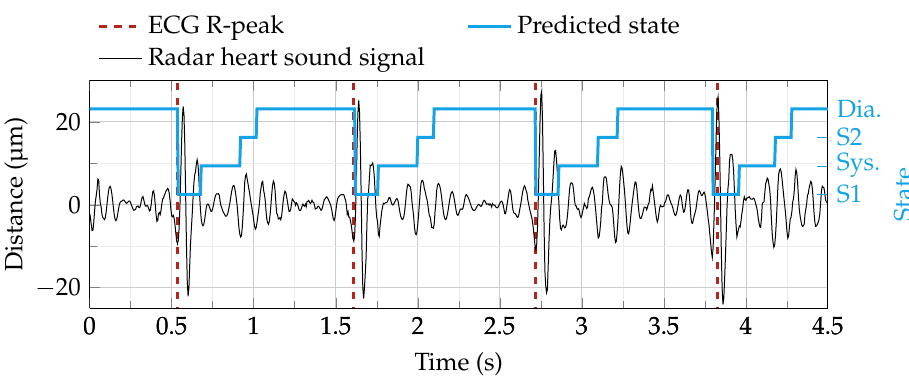
Figure 9. Segmentation of a radar heart sound signal using the hidden semi-Markov model (HSMM) algorithm [43]. The segmentation procedure predicts four states (blue line): First heart